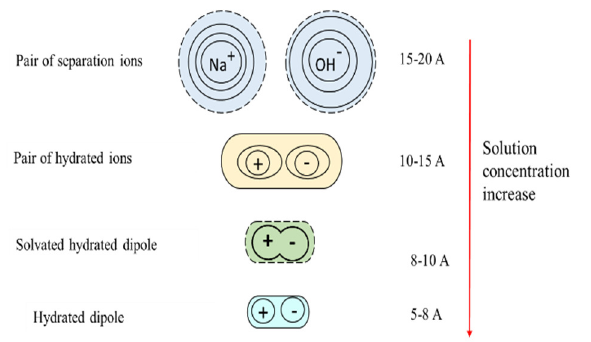
Fig. 7. Hydrodynamic diameter of hydrates with respect to NaOH solution concentration